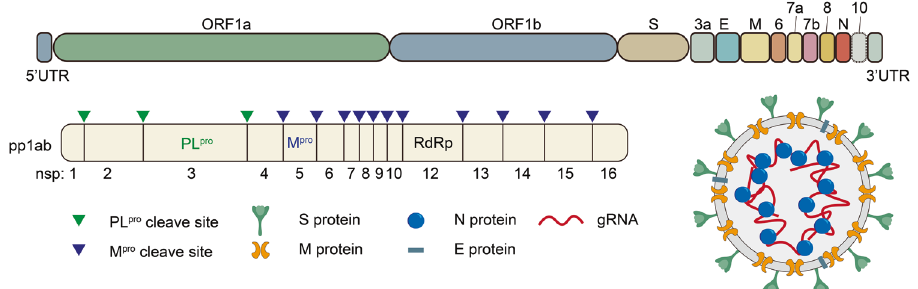
Fig. 1 Schematic illustration of the genome of SARS-CoV-2 and its structure. The size of SARS-CoV-2 genome is close to 30 kb; it contains 14 open reading frames (ORFs) and encodes 29 proteins. Two ORFs, comprising approximately two-thirds of the genome, encode two polyproteins, which are digested by M protease (M pro ) and Papain-like protease (PL pro ) into 16 nonstructural proteins (nsps). Four ORFs encode a series of structural proteins, including the spike (S), membrane (M), envelope (E), and nucleocapsid (N) proteins